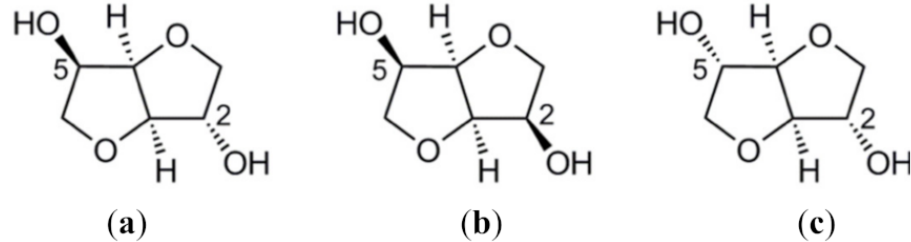
Figure 8. Stereo-isomeric forms of isohexides: isosorbide ( a ), isomannide ( b ), and isoidide ( c